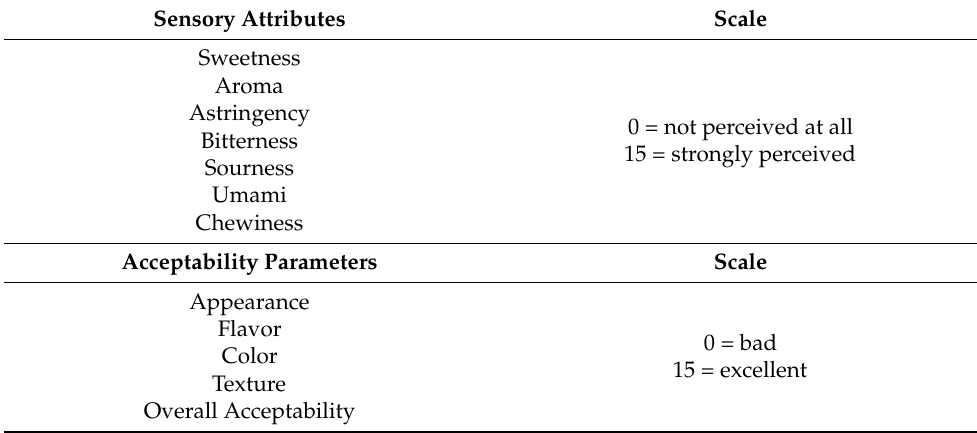
Table 1. Sensory attributes and acceptability parameters evaluated in the consumer test. The fruiting bodies were assessed by seven sensory attributes and five acceptability parameters. The 15-cm labelled scale (LMS) was used to conduct the